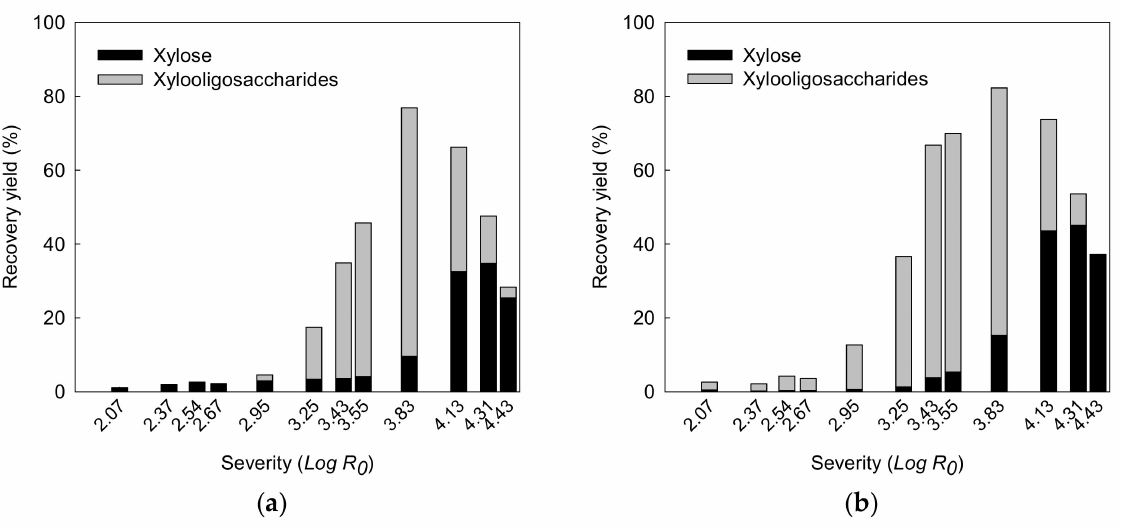
Figure 6. Xylose and xylooligosaccharide contents of liquid hydrolysates (HW and HW-CM pretreat- ment; Log R 0 = 2.07–4.43). ( a ) HW treatment and ( b ) HW-CM treatment. Reaction conditions: temper- ature 120 ◦ C, 150 ◦ C and 180 ◦ C; reaction time 30 min, 60 min, 90 min, and 120 min; L/S = 10 mL/g. The liquid hydrolysates obtained from CM-HW pretreatment at Log R 0 = 3.43, 3.55, and 3.83 were analyzed to determine the MW distribution by the GFC system, as shown in Figure 7. The highlighted range indicates a MW between 150 and 1400, which corresponds to the degree of polymerization between 1 and 10 xylose units (i.e., xylose: 150.13 g/mol, xylodecaose: 1339.17 g/mol). At Log R 0 = 3.83, the distribution of low MW (<150) was predominant compared with that of high MW (>1400), and the pretreatment at Log R 0 = 3.43 and 3.55 showed a contrasting trend. In this graph, low MW (<150) substances are assumed to be byproducts or decomposition products such as acetic acid (60.05 g/mol), formic acid (46.03 g/mol), furfural (96.08 g/mol), levulinic acid (116.11 g/mol), and 5-HMF (126.11 g/mol).